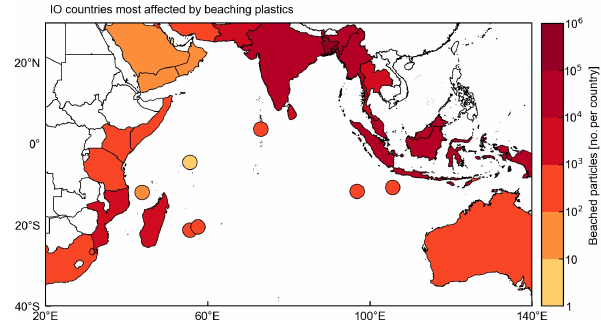
Figure 6. Countries and islands in the Indian Ocean most affected by beaching plastics from river sources. Colours show the number of particles that have beached in each country in Lagrangian par- ticle tracking simulations by van der Mheen et al. (2020a), where particles beach with a 50% chance if they come within 8km of a coastline. Figure adapted from van der Mheen et al. (2020a). Please note that country boundaries are obtained from outputs of scientific computer simulations and may not represent political and/or geo- graphical